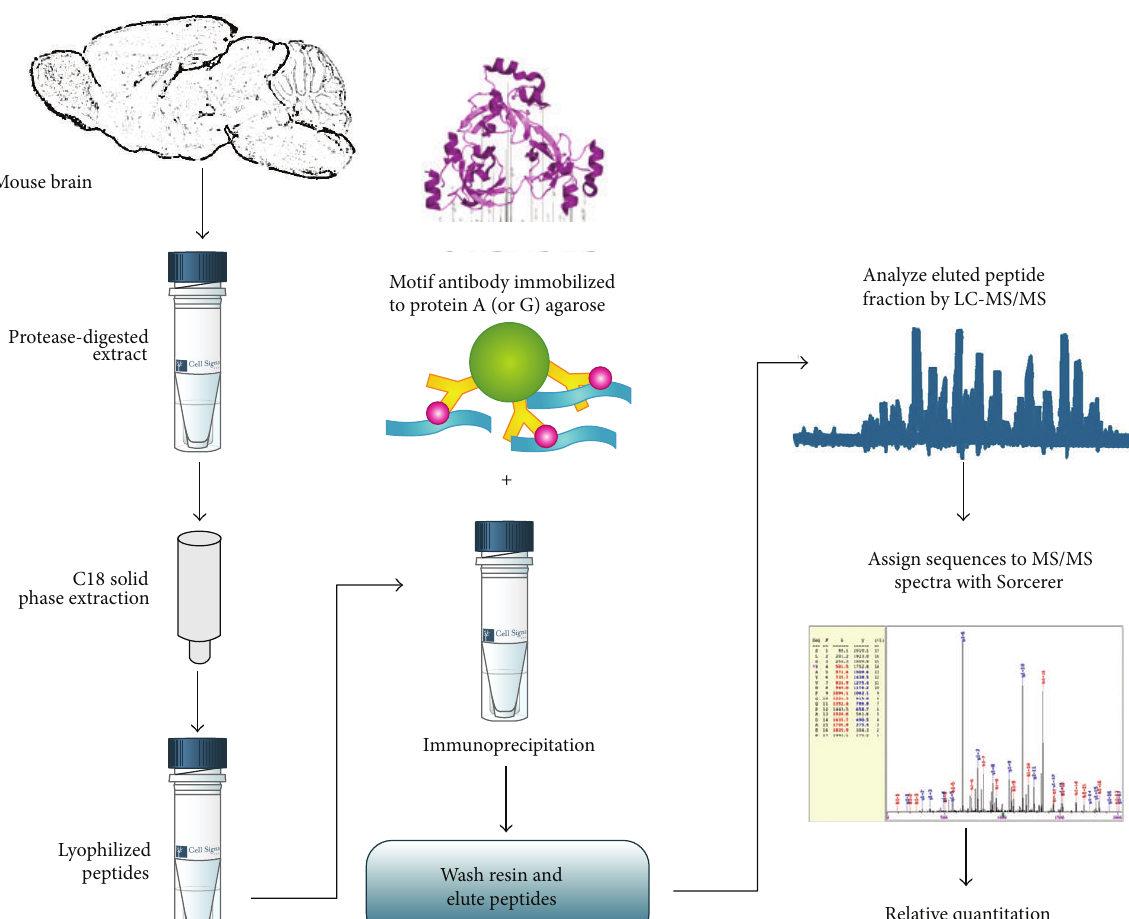
Figure 1: Workflow chart illustrating the technical approach to quantify the mono-methyl-arginine-modification of peptides throughout the global brain proteome in a quantitative and label-free manner by immunoprecipitation and mass spectrometry. The immunoprecipitation step illustrates the motif antibody (above), the agarose beads (green circle), its immunoglobulin coating (yellow), and the binding of digested peptides (blue) with mono-methyl-arginine modifications (pink). Graphic elements from internet-sites (http://www.cellsignal.com/ common/content/content.jsp?id=proteomics-discovery and http://media.cellsignal.com/www/pdfs/proteomics/methylscan workflow.pdf) were used with permission of Cell Signaling